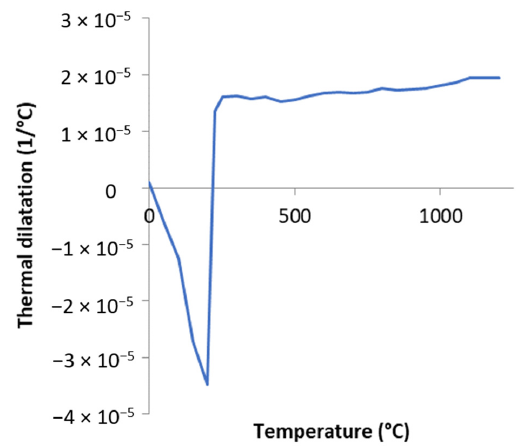
Figure 9. Thermal expansion coefficients for M4 from bulk sample (bainite/martensite) obtained with quenching cooling of 200 °C/s.